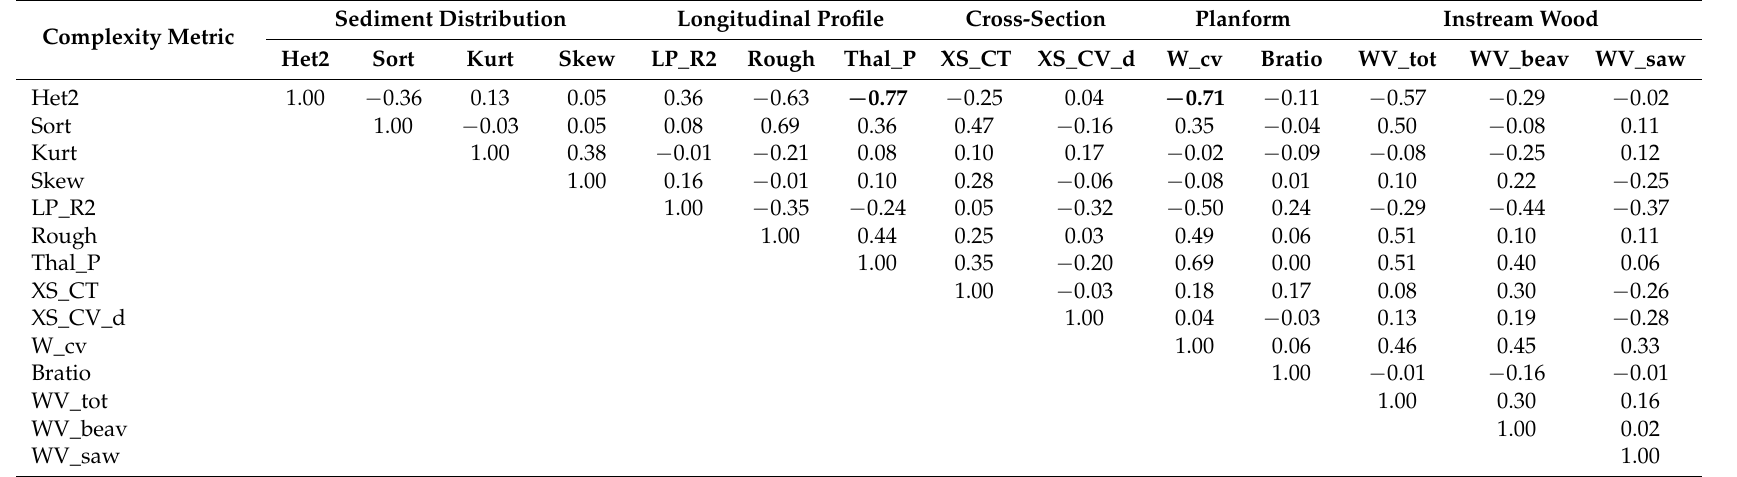
Table A1. Correlation matrix of the 14 (out of 29) measured geomorphic complexity metrics retained in [22] for all 20 study reaches. We reduced them further to 12 by excluding variables with a Pearson’s correlation coefficient >0.7 from further analysis; Th_P and W_cv were removed. Pearson’s correlation coefficients >0.7 are in